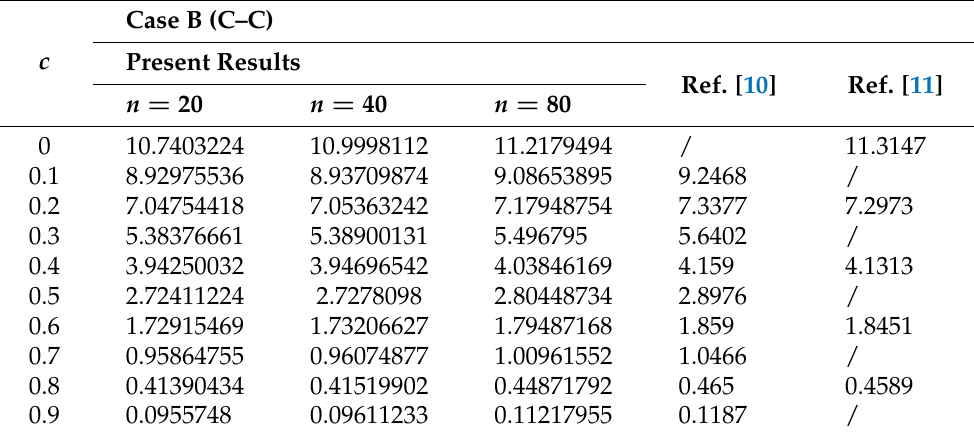
Table 6. Dimensionless critical load of a C–C axially FG Timoshenko beam with different taper coefficient ( m =